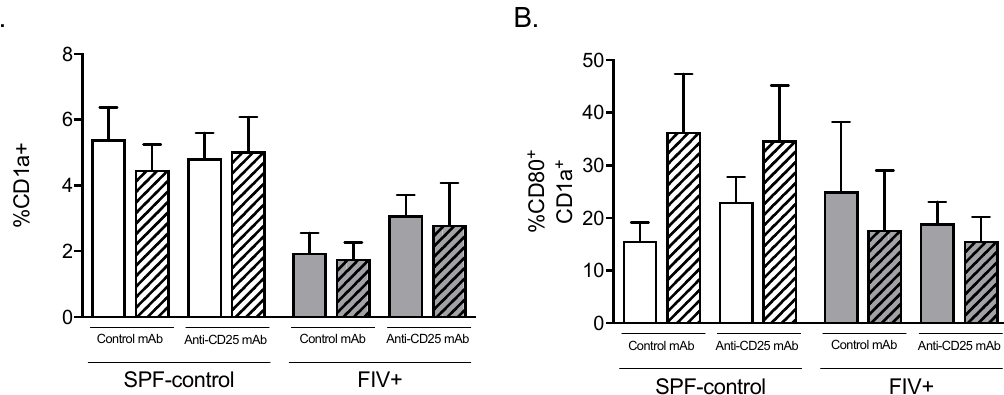
Figure 7. The e ff ect of Treg depletion on dendritic cell (DC) percentage and activation status. Cats were treated with isotype control mAb or anti-CD25 mAb and cells from the control lymph node (open bar) and Lm-draining lymph node (hatched bar) were analyzed by flow cytometric analysis. ( A ) Percentage of CD1a + DC and ( B ) percentage of CD1a + DC expressing CD80. Gating included all nucleated lymph node cells. Statistical analysis was performed using one-way ANOVA with Tukey’s post-test. No significant di ff erences were identified; n = 6 for each treatment group.